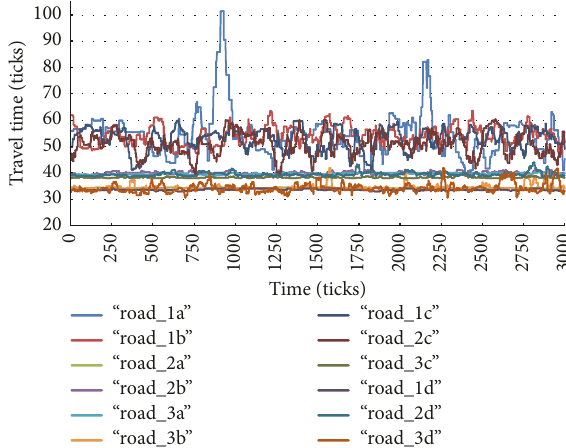
Figure 7: Time-dependent change of travel time under the con- nected vehicle environment.